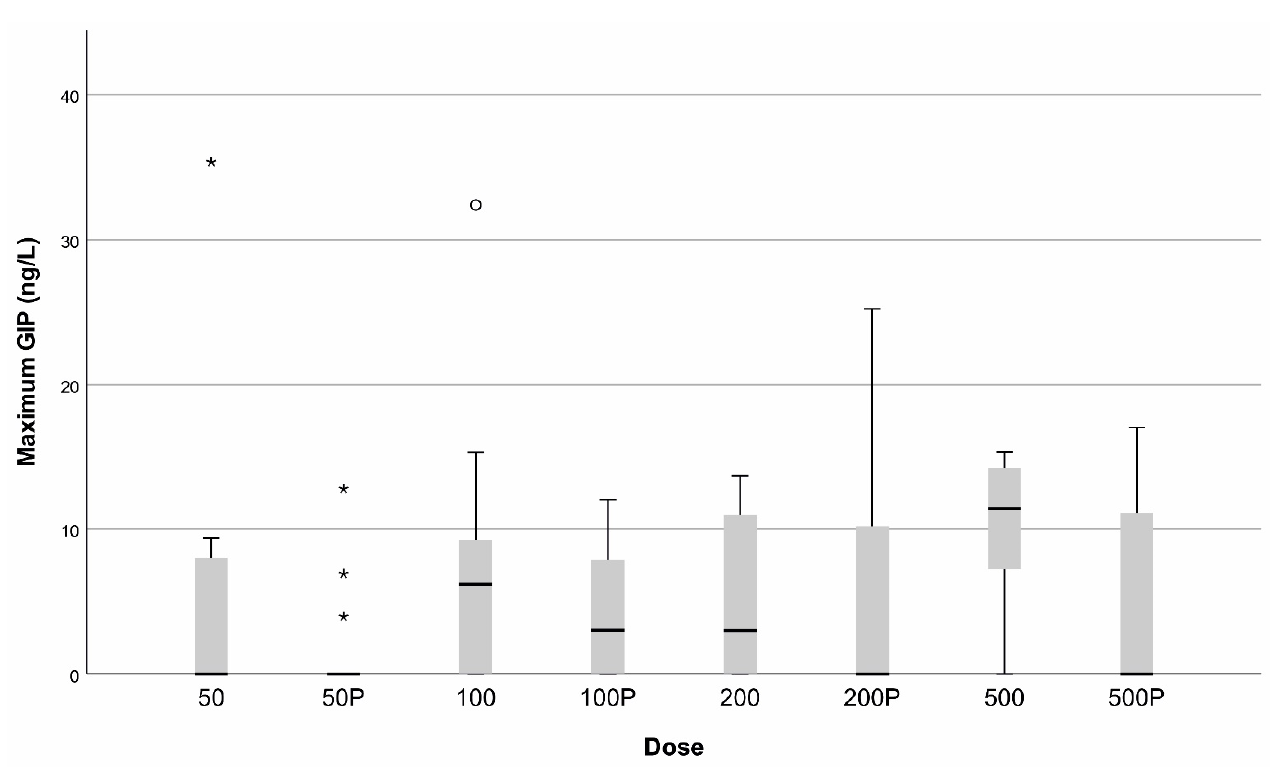
Figure 4. Maximum concentration of gluten immunogenic peptides (GIP) in ng/mL in urine after gluten or placebo ingestion. x -axis: dose of gluten or placebo (p). y -axis: concentration of GIP in urine in ng/L. Values more than three interquartile range from the end of a box are labeled as extreme, denoted with an asterisk (*). Values more than 1.5 but less than 3 interquartile range from the end of the box are labeled as outliers (o).